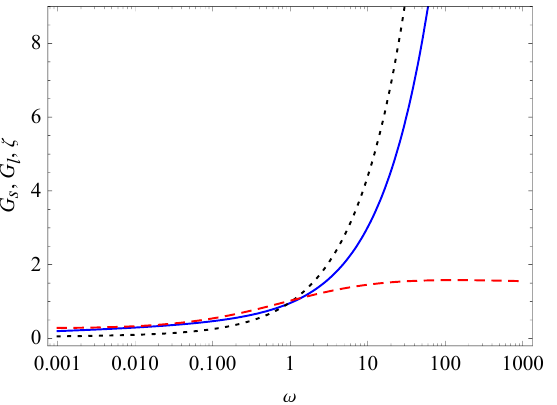
Figure 6. Curves of G s (solid line), G l (dotted line), and ζ (dashed line) versus ω for a = 1, b 1 = 1, b 2 = 2, α = 0.6, and β = 0.8 in the fractional five-parameter model (68).